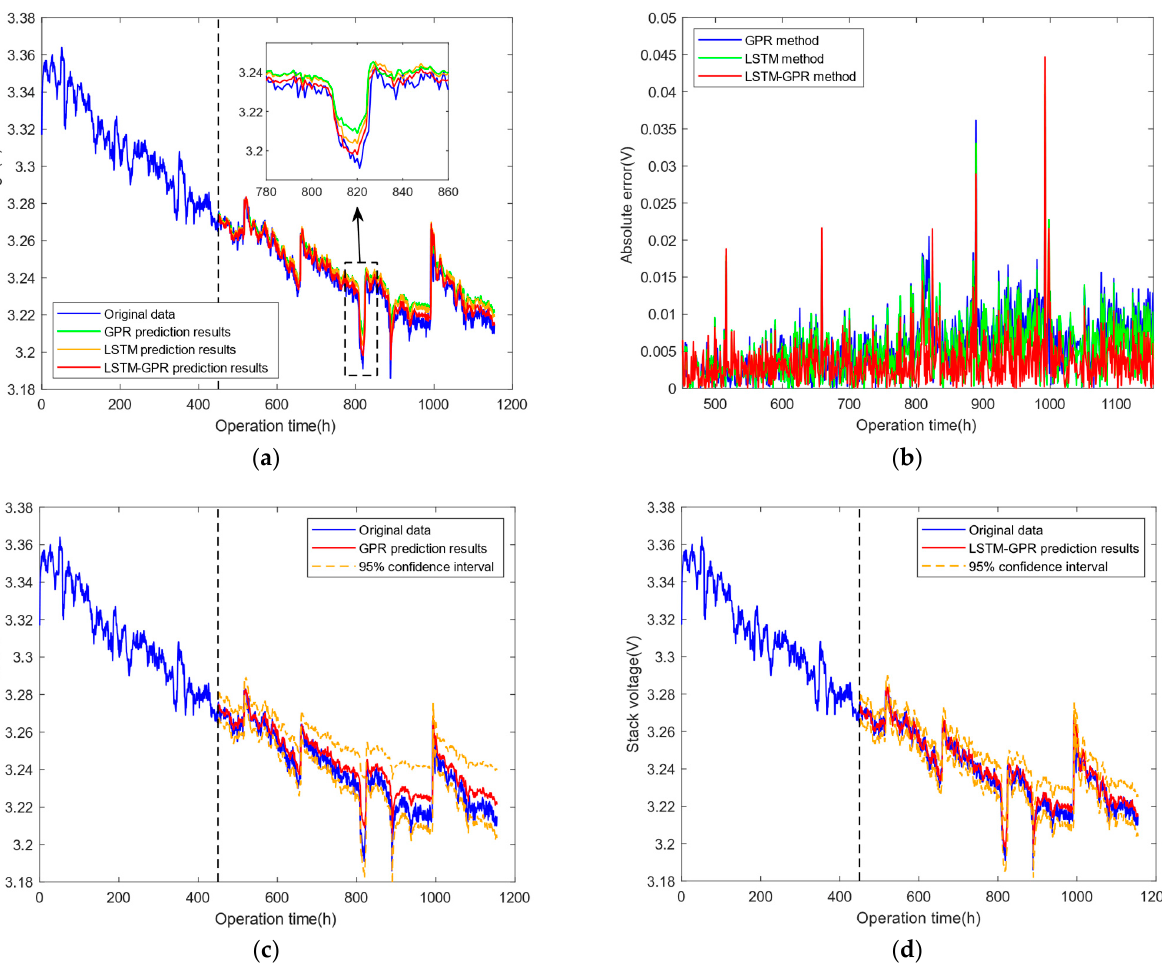
Figure 5. Comparison of the prediction performance of the proposed LSTM-GPR method with the individual models: ( a ) voltage prediction results of the three methods; ( b ) absolute error of the three methods; ( c ) GPR prediction result; and ( d ) LSTM-GPR prediction results.